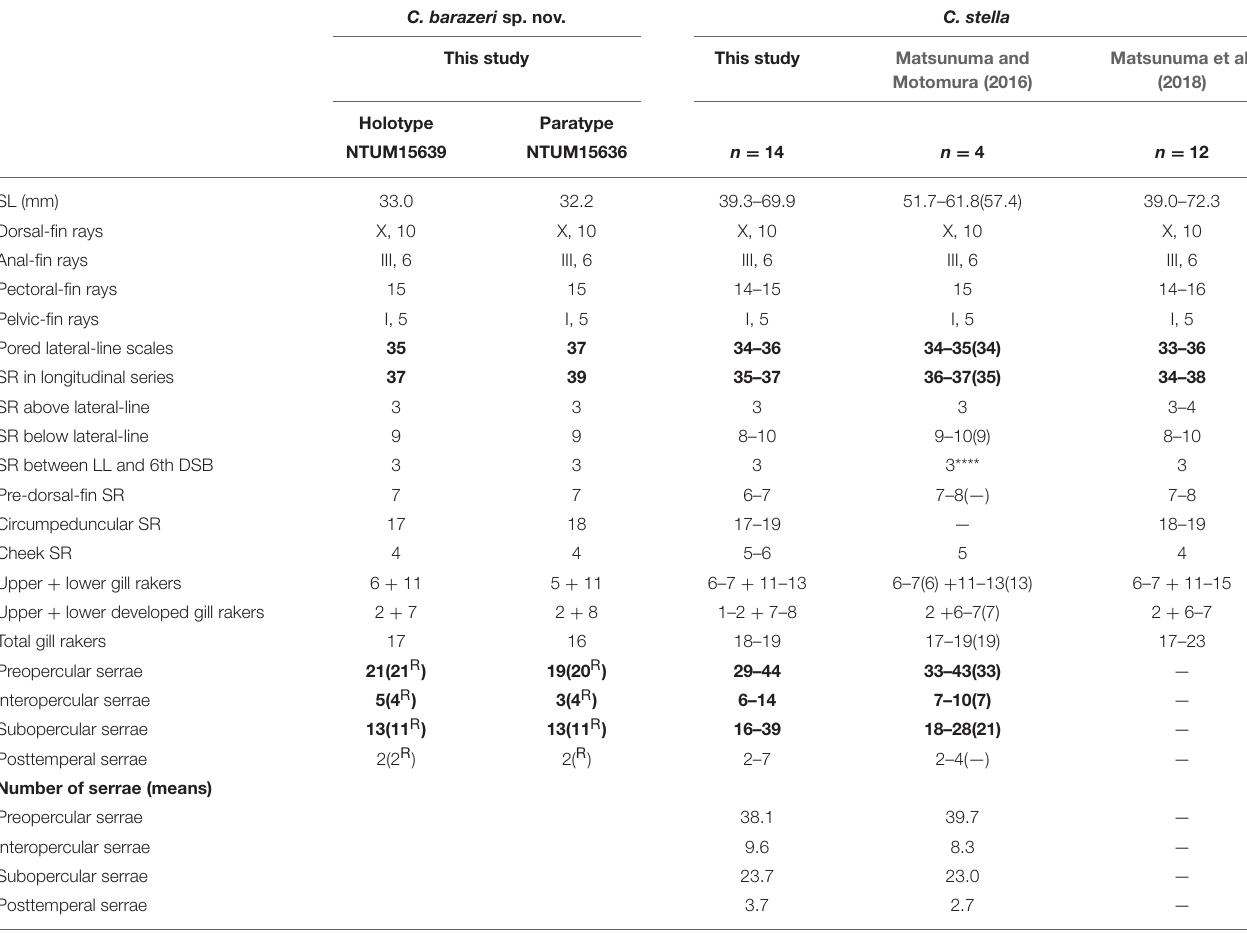
TABLE 3 | Meristic features of Chelidoperca barazeri sp. nov. and C. stella (including examined specimens and reference data); bold font presents distinguishing characteristics; parentheses in Matsunuma and Motomura (2016) contains holotype